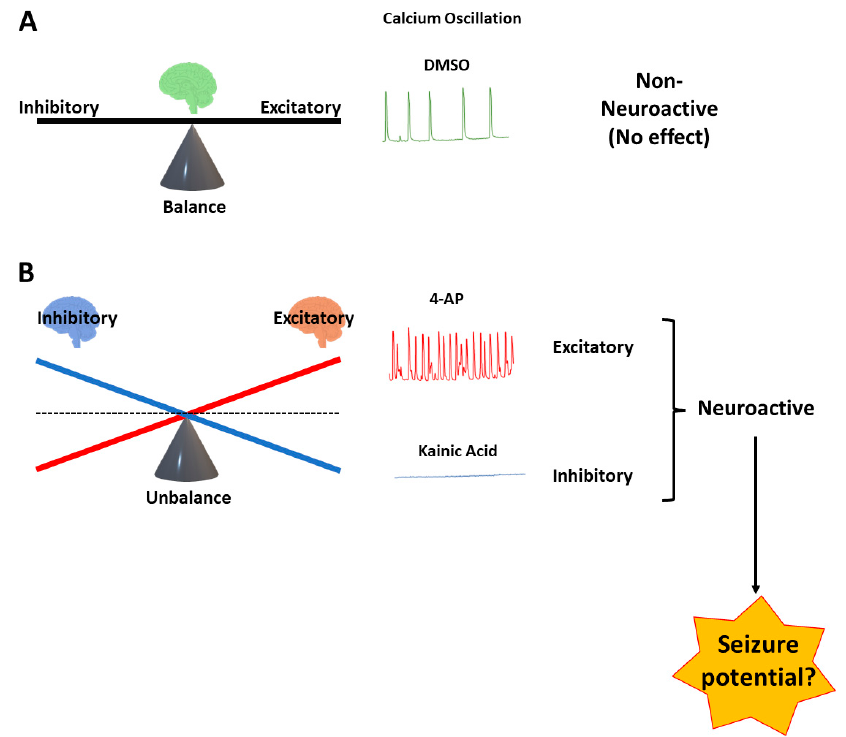
Figure 1. Schematic representation showing a simplified paradigm to understand the balance and the imbalance between excitatory and inhibitory neuronal activity based on changes in Ca 2+ neuronal oscillations in hiPSC-derived neurons cultured with astrocytes. Upper panel ( A ) non-neuronally active response (e.g., 0.1% DMSO) shows no change in baseline oscillations; lower panel ( B ) neuronally active compounds can produce large increases in (e.g., 4-AP at 30 µM) or inhibition (e.g., kainic acid at 10 µM) of Ca 2+ neuronal oscillations. Drug-induced large increases or decreases in Ca 2+ neuronal oscillations, which tip the balance toward excitation or inhibition, are most likely involved in the potential risk for seizure activity.